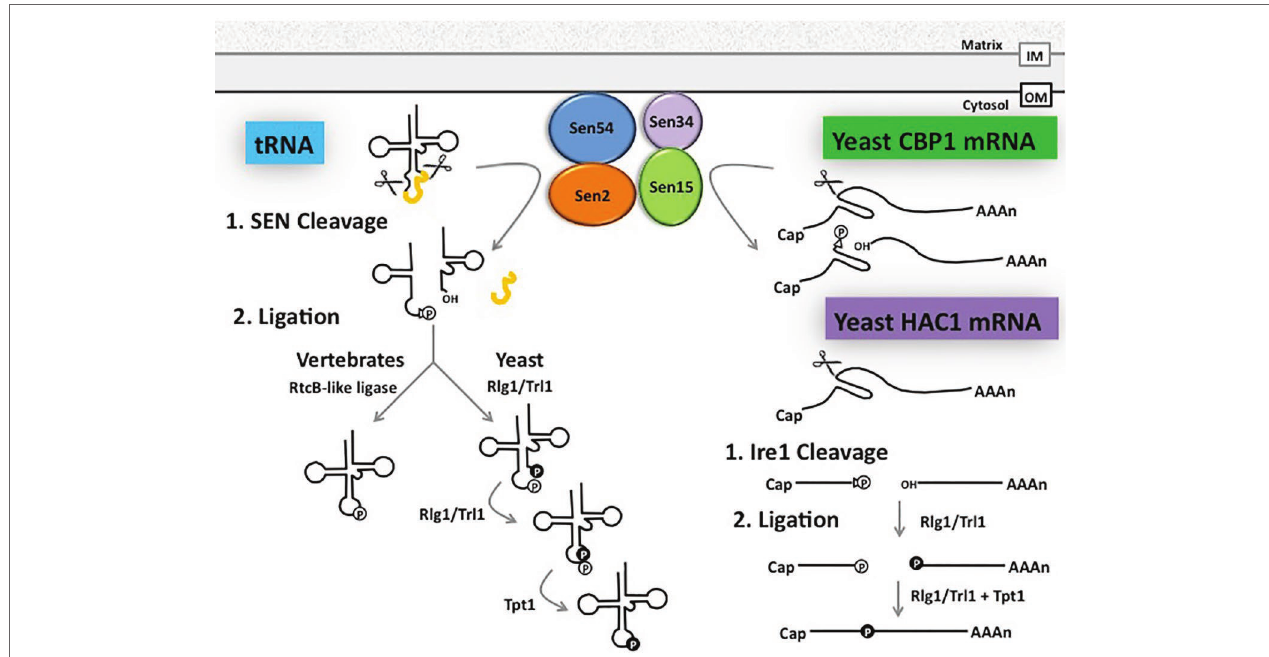
FIGURE 4 | Shared pathways for splicing and ligation of tRNA and mRNA. tRNA introns (depicted in yellow) are removed by the heterotetrameric SEN complex at the outer surface of the mitochondrial membrane in budding and fission yeast, generating a 2 ′ -3’cyclic phosphate (triangle and “P” in white circle) at the 3 ′ end of the 5 ′ exon and a hydroxyl group at the 5 ′ end of the 3 ′ exon. In budding yeast, the tRNA 5 ′ and 3 ′ exons are ligated by Rlg1/Trl1 in the cytoplasm in a series of reactions beginning with the phosphorylation of the 5 ′ hydroxyl group (“P” in black circle) of the 3 ′ exon and decyclization of the 2 ′ -3 ′ cyclic phosphate to a 2 ′ phosphate (“P” in white circle) on the 5 ′ exon. These exons are then joined using the 5 ′ phosphate, leaving the 2 ′ phosphate at the splice site to be transferred to NAD by Tpt1. In vertebrates, however, the vertebrate ligase directly joins the 2 ′ -3 ′ cyclic phosphate of the 5 ′ exon to the 3 ′ exon. The SEN complex also functions in the clipping of CBP1 mRNA and Rlg1/Trl1 ligates HAC1 mRNA exons generated by a protein endonuclease. Additional, but currently unidentified, RNAs are likely also processed by the SEN complex (see text). OM: Outer mitochondrial membrane, IM: Inner mitochondrial